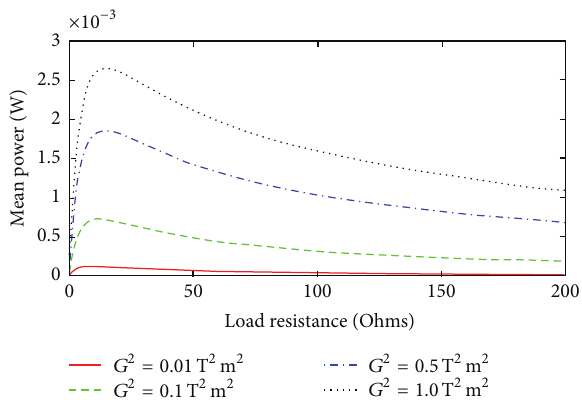
Figure 15: Mean power as a function of load resistance for different values of 𝐺 2 with spring scaling factor 𝜂 = 5 m −2 and the damping scaling factor 𝛼 = 5 s 2 m −2 at SD = 0.01 g 2 /rad/s.